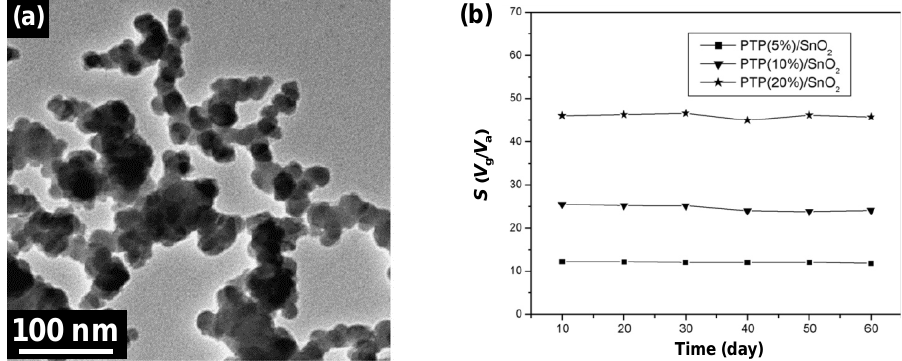
Figure 9. ( a ) TEM image of PTP (20%)/SnO composites; ( b ) The stability of PTP/SnO 2 sensor to 100 ppm NO . Adapted with permission from [54]; Copyright 2012, x